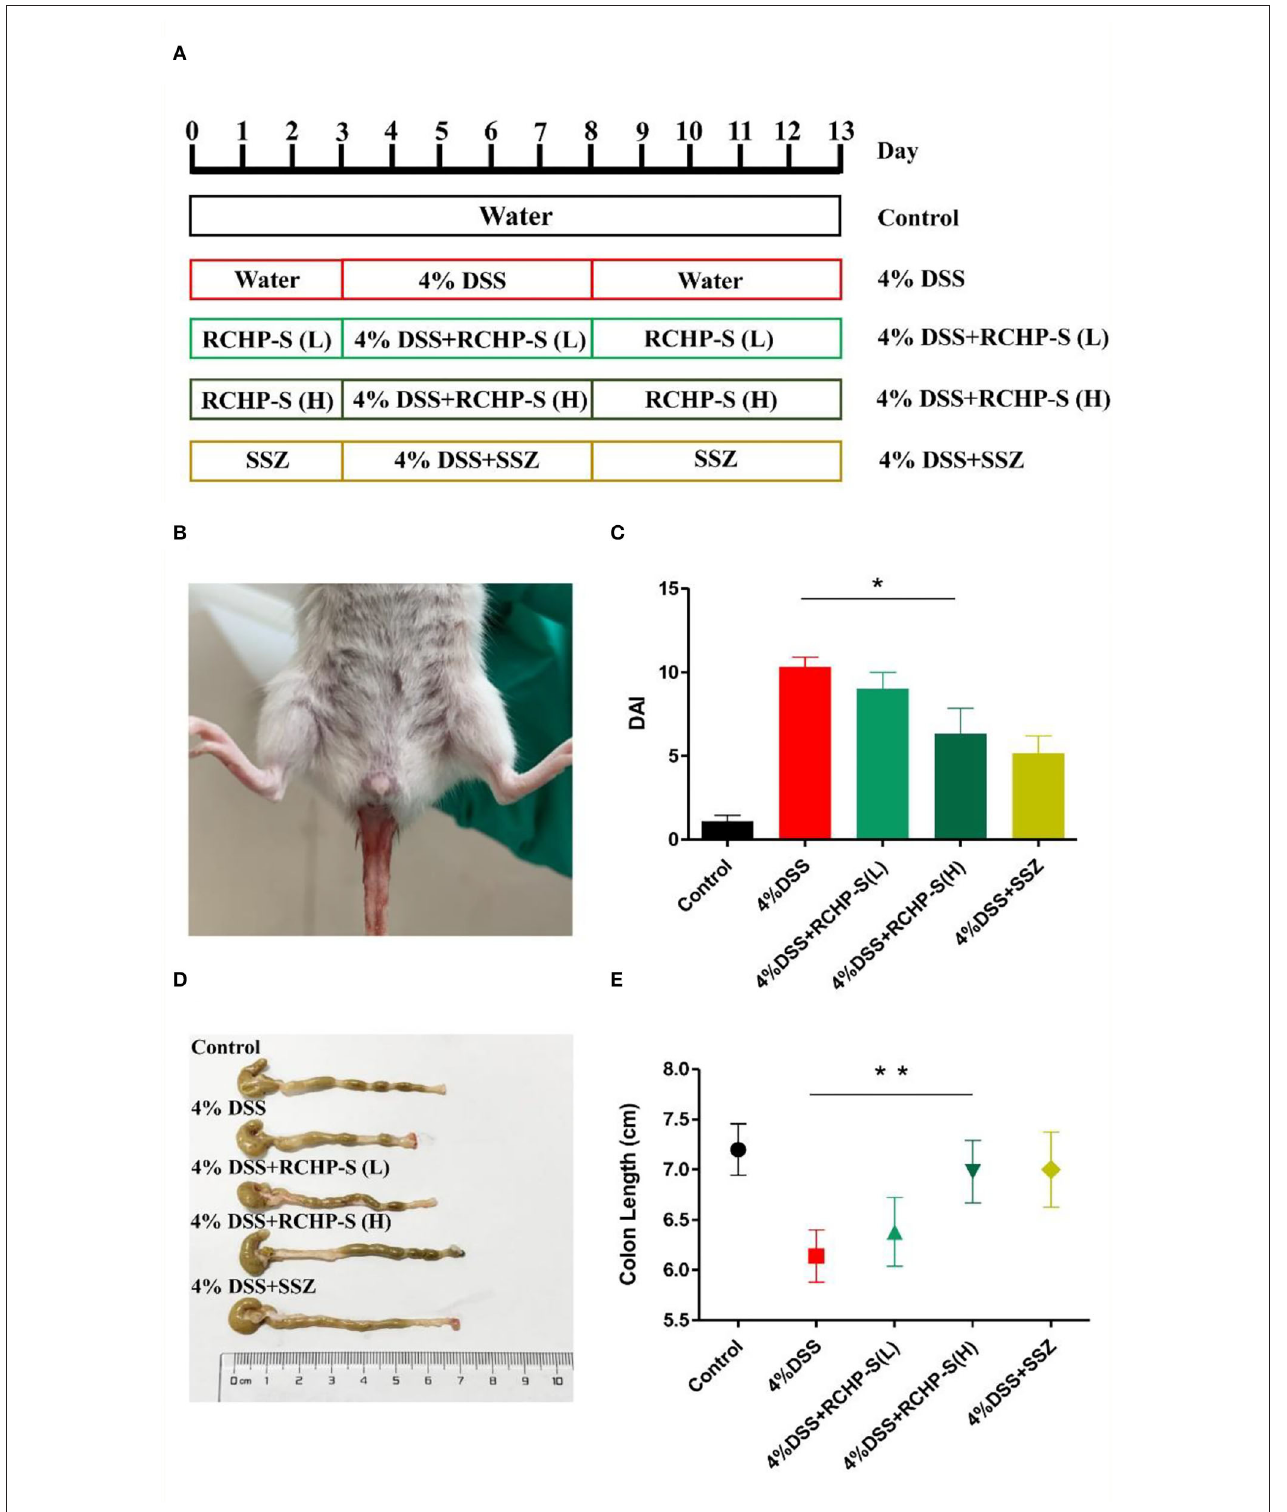
FIGURE 7 | (A) Establishment model of mouse enteritis, (B) clinical symptoms of colitis (hematochezia) in mice, (C) DAI scores, (D) colon morphology from mice in different groups, and (E) change in colon length. * p < 0.05, ** p < 0.01.